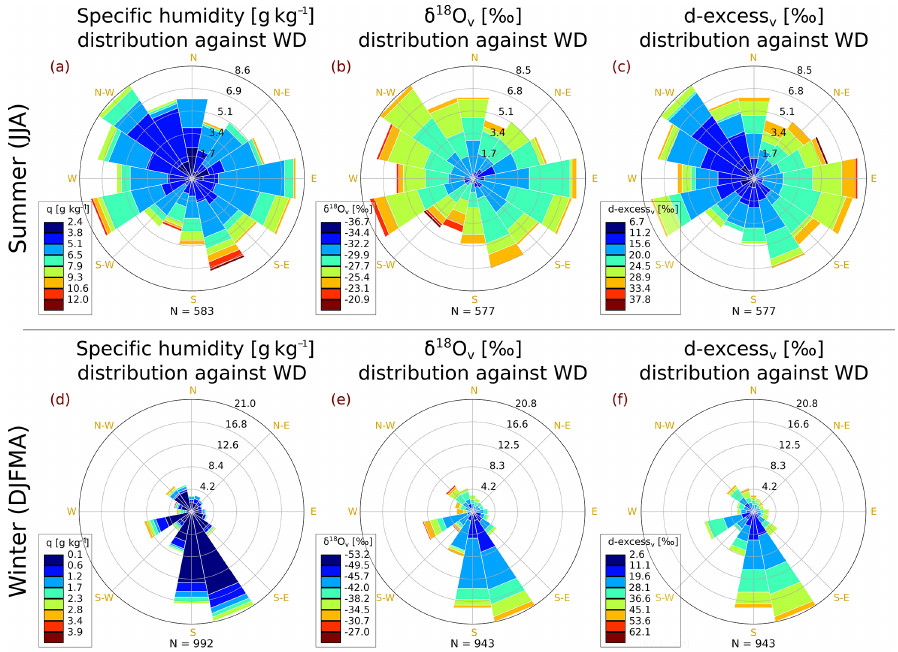
Figure 8. Percent distribution of (a, d) specific humidity, (b, e) δ 18 O v and (c, f) d -excess v for (a, b, c) the summer months only (June to August) and (d, e, f) the cold months only (from December to April). The percent distributions are given with respect to the different wind directions